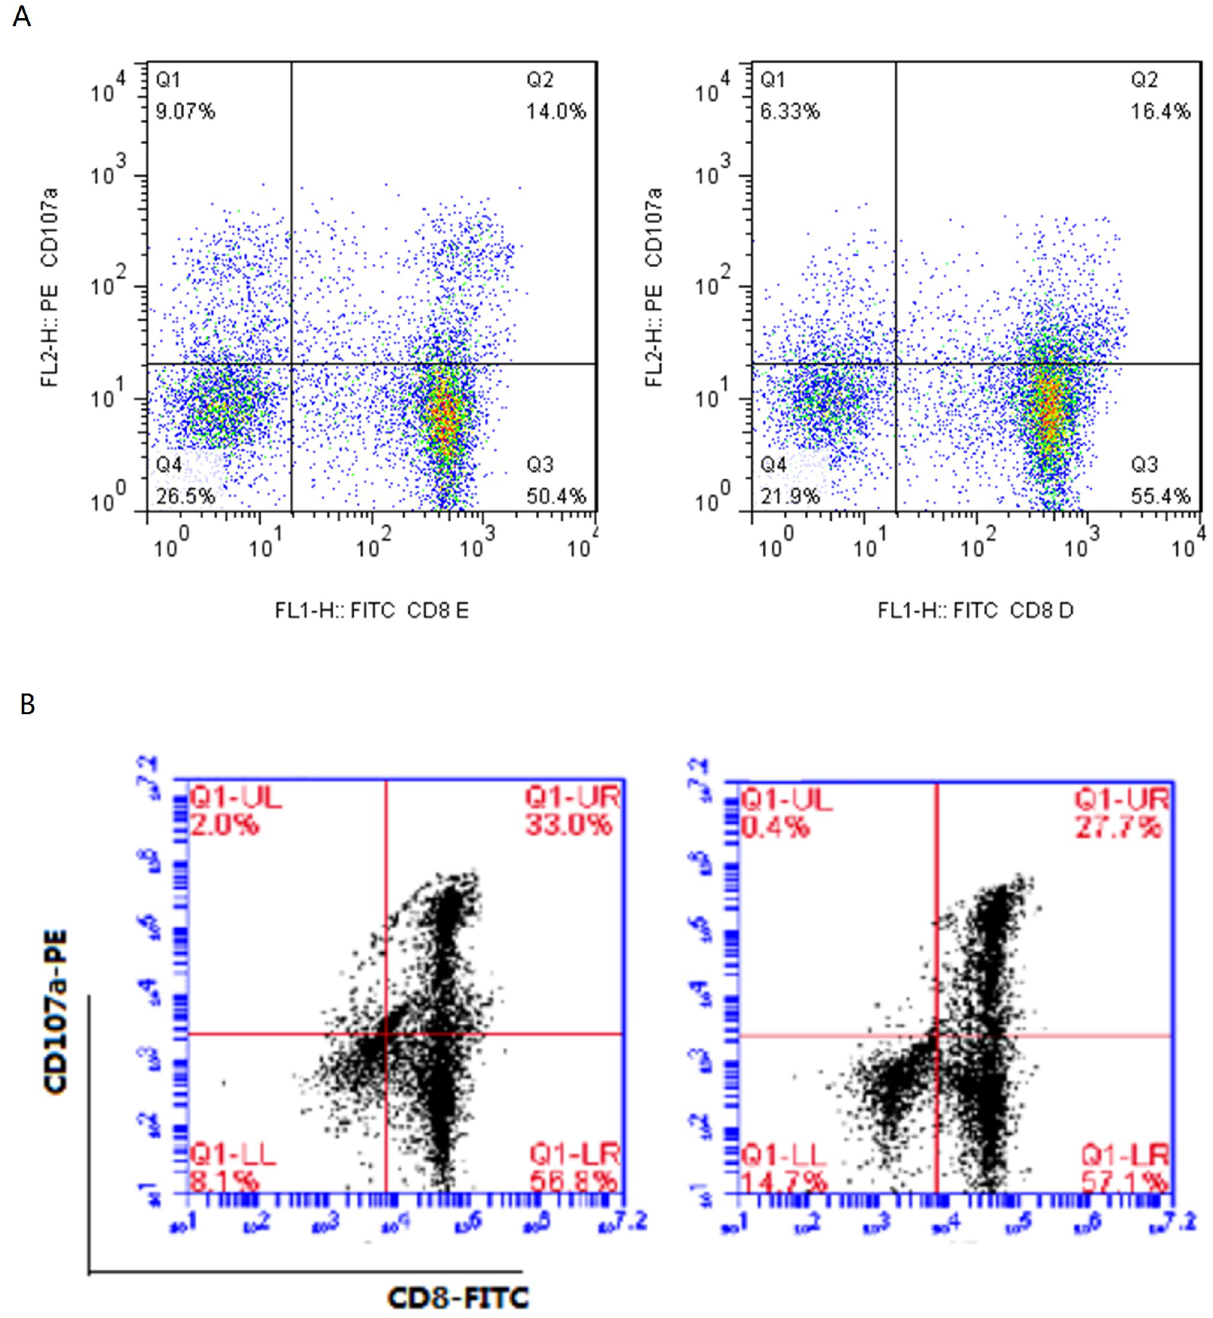
Fig 3. OCT4 and Sox2 antigens induced CD8+ T cell degranulation. A, PBMC were treated with OCT4 and Sox2 polypeptide antigenfor 4 h and subjectedto flow cytometry analysisof CD8+ CD107a+ cells. B, CIK cells were stimulatedwith 10 g/ml OCT4 or Sox2 antigen48 hr prior to MACS sorting, and the sorted CD8+ CIK cell were cultured for additional2 weeks, followedby flow cytometry analysisof CD8 + CD107a+ cells. left: OCT4 antigenstimulation;Right: Sox2 antigenstimulation.